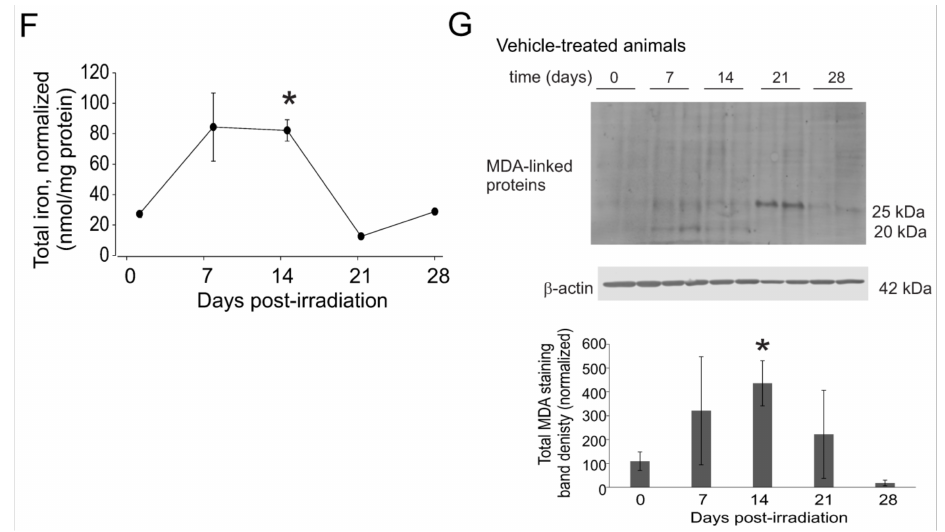
Figure 7. Total body irradiation results in biphasic alterations in spleen weight and increased expression of markers for cell death and ferroptosis in the spleen. C57BL/6 mice were exposed to 6.85 Gy total body irradiation. Animals received vehicle (drinking water alone) or captopril in the drinking water on days +2–+16 post-irradiation. At the indicated time points, mice were euthanized, and spleen tissue was obtained. Spleen weight and total body weights were obtained, and spleen tissues were used for western blotting and qPCR. ( A ) Spleen weights as a percentage of total body weight. Graph shows means ± SEM, n = 4 animals. * indicates p < 0.05 from control (0 time point). † indicates p < 0.05 compared with the vehicle-treated group at 21 days post-irradiation. ( B ) Western blots of total and activated caspase 3; blots were reprobed for β -actin as a loading control. The left panel shows vehicle-treated animals; the right panel shows captopril-treated animals. Representative data are shown from n = 2 animals from each group. Graphs show means ± SEM, n = 4 animals; * indicates p < 0.05 from control (0 time point). ( C , D ) Spleen tissues from sham irradiated (0 time point), vehicle-treated, or captopril-treated animals were used for qPCR for glutathione peroxidase 4 ( Gpx4 ; ( C )) or solute carrier family 7 A 11 ( Slc7a11 ; ( D )). Graphs show means ± SEM, n = 4 animals; * indicates p < 0.05, *** p < 0.001, and **** p < 0.0001 from control (0 time point). † indicates p < 0.05 from the vehicle-treated group at the same time point. ( E ) Western blots of COX-2; blots were reprobed for β -actin as a loading control. The left panel shows vehicle-treated animals; the right panel shows captopril-treated animals. Representative data are shown from n = 2 animals from each group. Graphs show means ± SEM, n = 4 animals; * indicates p < 0.05 from control (0 time point). ( F ) Iron assay of vehicle-treated spleen samples. Graphs show means ± SEM, n = 3–4 animals; * indicates p < 0.05 from control (0 time point). ( G ) Western blots of MDA-linked proteins in a non-reducing gel. Samples were probed for β -actin as a loading control in a denaturing gel. Representative data are shown. Graphs show means ± SEM, n = 3–4 animals; * indicates p < 0.05 from control (0 time